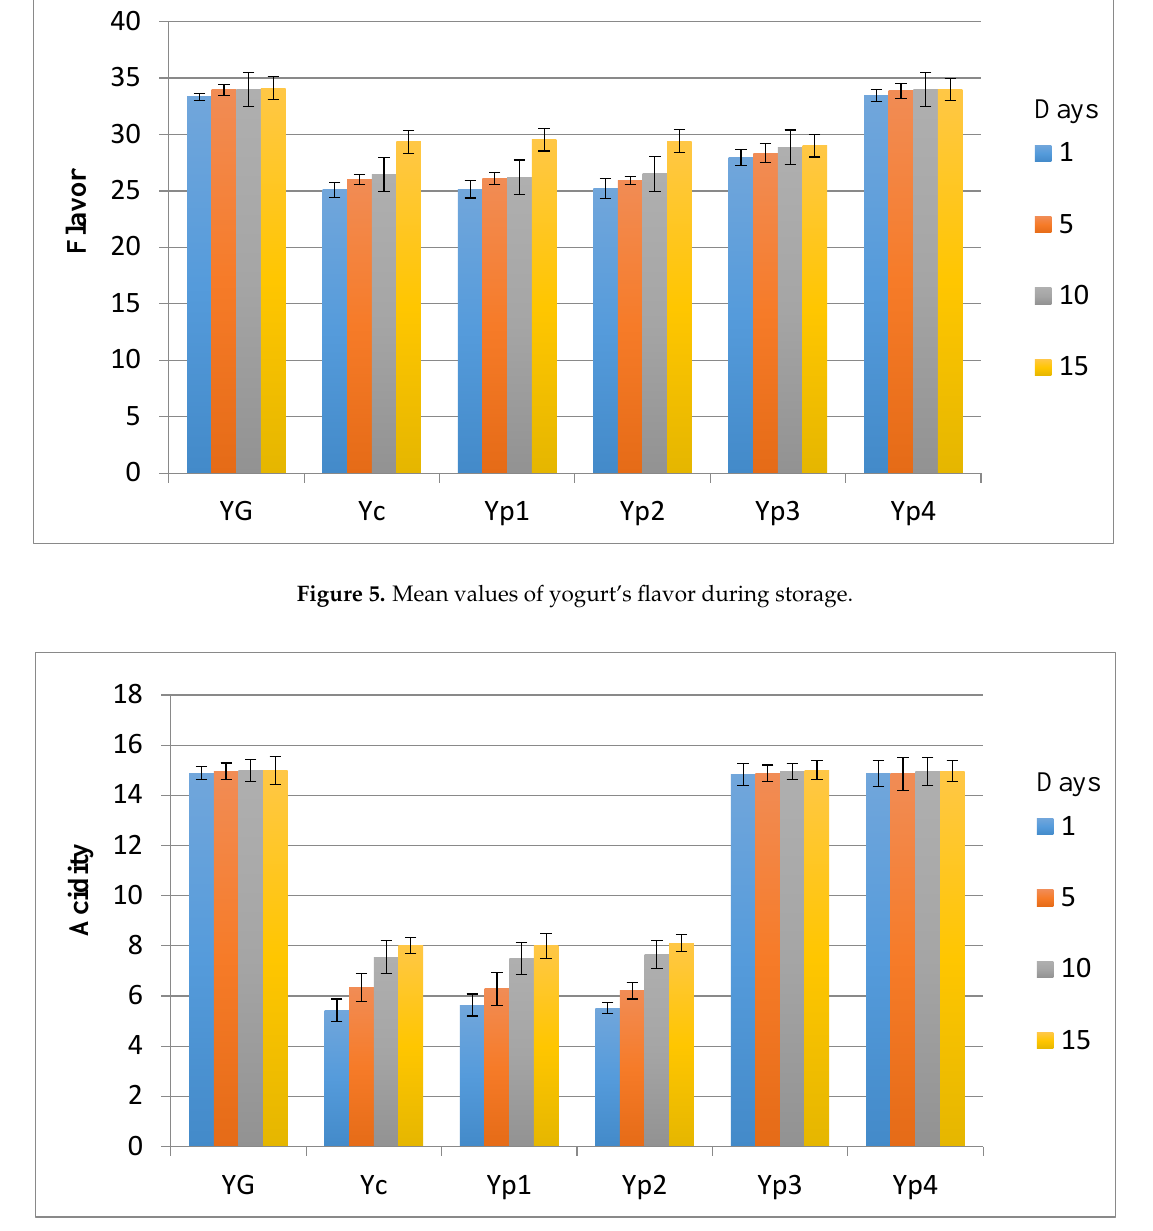
Figure 6. Mean values of yogurt’s acidity during storage.